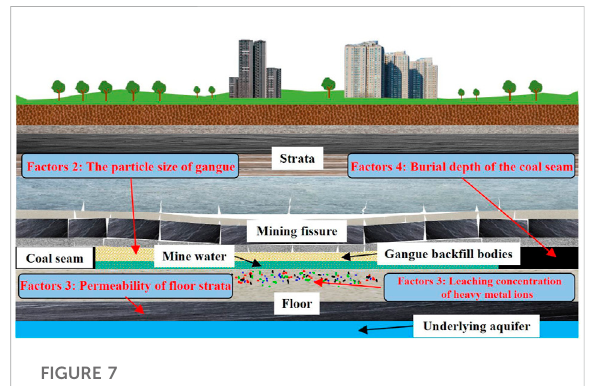
FIGURE 6 The histograms of the migration distances of Mn ions at different times.